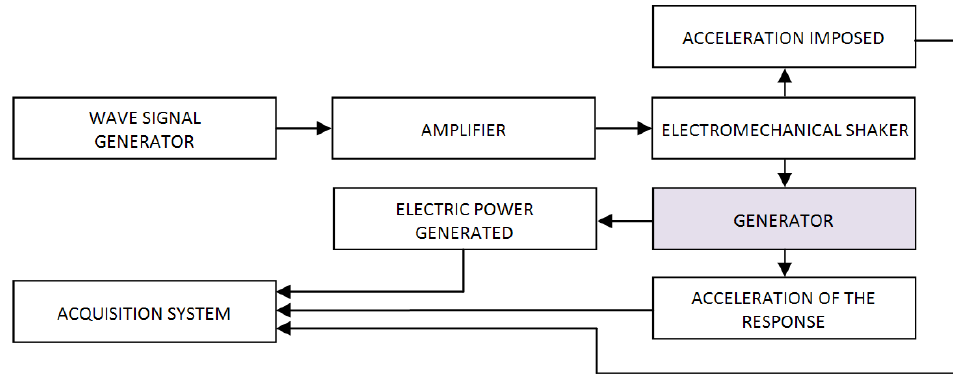
Figure 6: Blocks diagram of the test bench for the experimental characterization of the